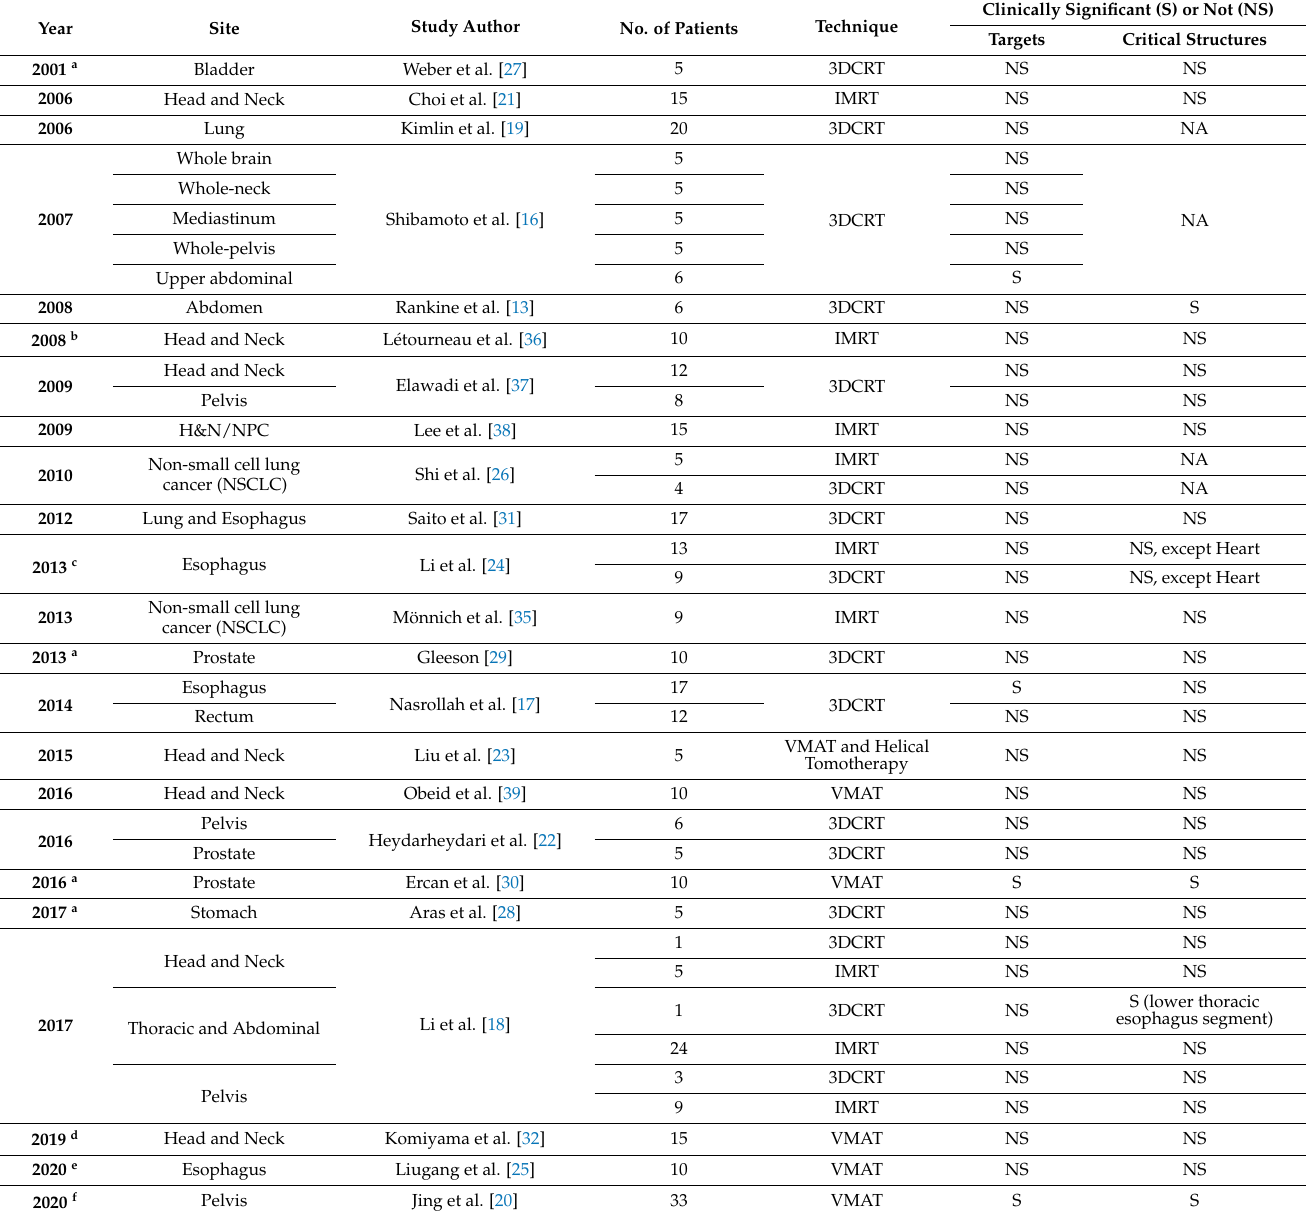
Table 1. Literature search summary for the effect of contrast agents on radiotherapy dose calculations. Upper subscripts denote correction method used to overcome the effect of contrast material. a : resetting structure density to water equivalent density; b : changing structure density using structure density from diagnostic images for same structure; c : overriding the HU by other values; d : using virtual monochromatic images in DECT; e : using artificial intelligence to correct HU values; f : altering densities based on simulated CT